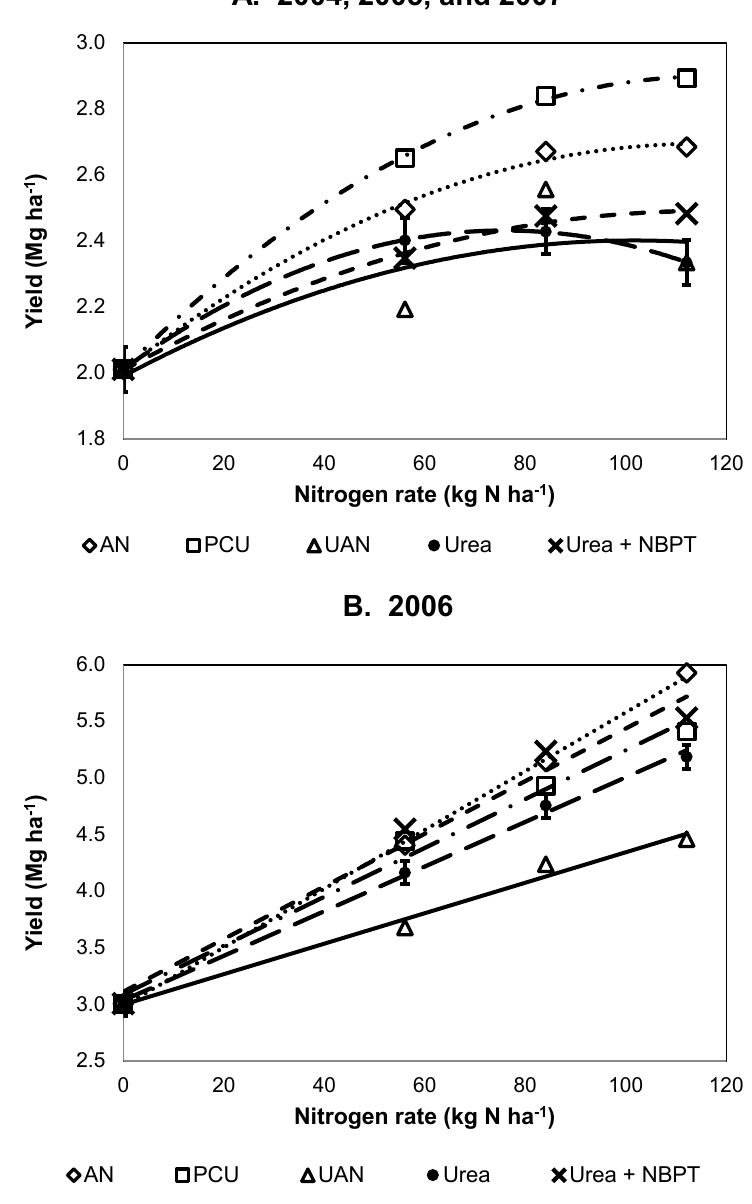
light penetration and red clover dry weights were positively correlated with light penetration; however, Vyn et al. [26] reported no effect of small-grain N rate on biomass yields of red clover. Figure 2. Wheat grain yield response to fall applied nitrogen sources (AN ( y = − 0.0521 x 2 + 11.961 x + 2008.6, R ² = 0.99), ammonium nitrate; PCU ( y = − 0.0652 x 2 + 15.215 x + 2010.5, R ² = 0.99), polymer-coated urea; UAN ( y = − 0.0397 x 2 + 8.0771 x + 1990.8, R ² = 0.70), urea ammonium nitrate; urea ( y = − 0.0732 x 2 + 11.092 x + 2011.5, R ² = 0.99); and urea plus NBPT (N-(n-butyl) thiophosphoric triamide) ( y = − 0.0362 x 2 + 8.3498 x + 2009.2, R ² = 0.99)) and rates in 2004, 2005, and 2007 (top), and (AN ( y = 25.947 x + 2985.6, R ² = 0.99), PCU ( y = 21.552 x + 3089.6, R ² = 0.98), UAN ( y = 13.447 x + 2998.7, R ² = 0.98), urea ( y = 19.721 x + 3035.2, R ² = 0.99), and urea plus NBPT ( y = 23.239 x + 3114.4, R ² = 0.97)) in 2006 (bottom); vertical bars on the urea only treatment represent the standard